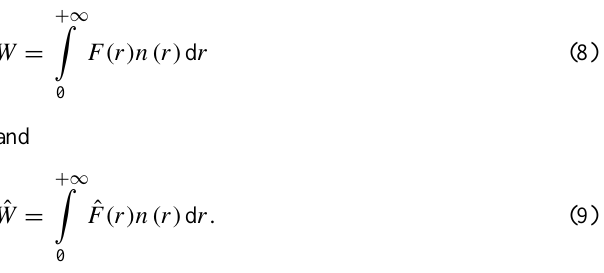
Fig. 3. Extinction coefficients versus LWC at λ = 4µm for the 20 size distributions considered in the paper. Each diamond has an ab- scissa equal to the LWC computed with Eq. (2) and an ordinate equal to the extinction coefficient computed with Eq. (3.) The solid line is the linear approximation proposed by Pinnick et al. (1979) (Eq. 5).